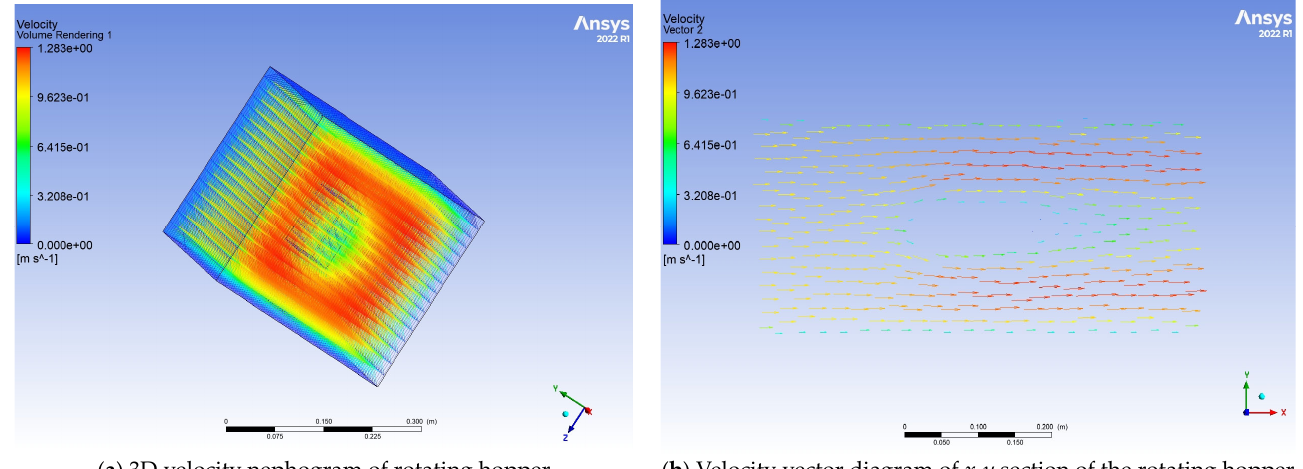
Figure 17. Curved surface diagram of time taken for the center of the pork to reach − 18 °C with changing flow rate and rotational speed.